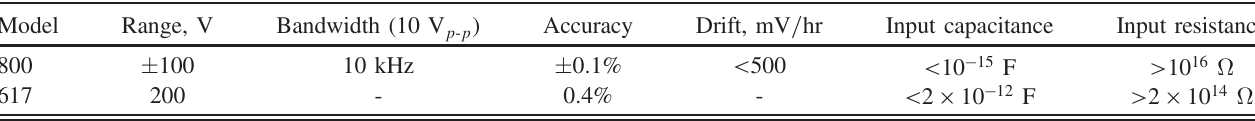
TABLE II. High-performance electrometer specifications.